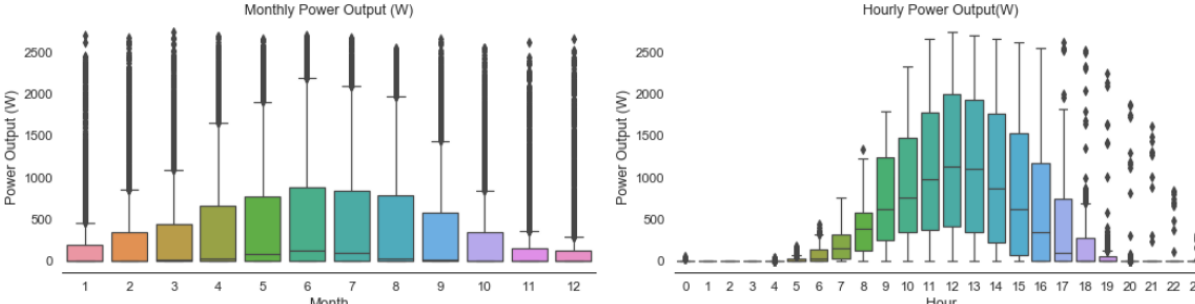
Figure 7: Monthly and hourly fluctuations of the power output